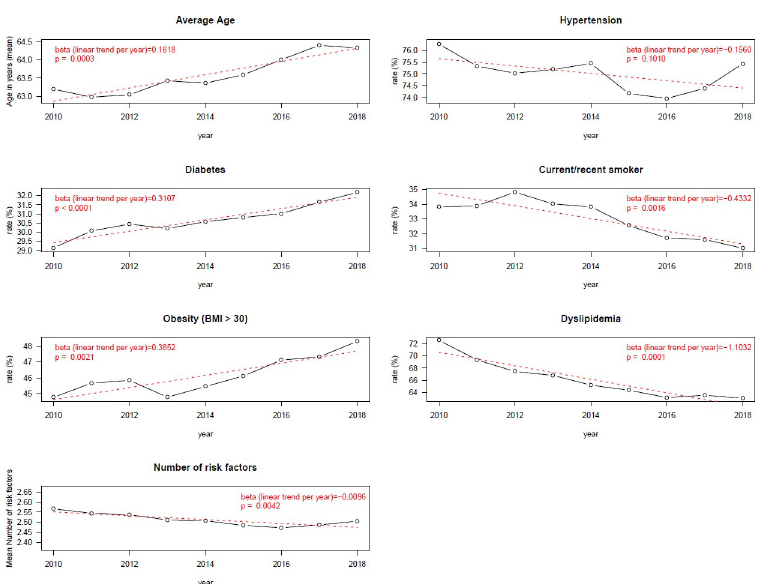
Fig 3. Trends in the prevalence of risk factors over the study period (2010–2018). The linear trend per year (beta coefficient) and its corresponding p-value (red text) are in the upper corner of each graph. The linear trend line is shown as a red dashed